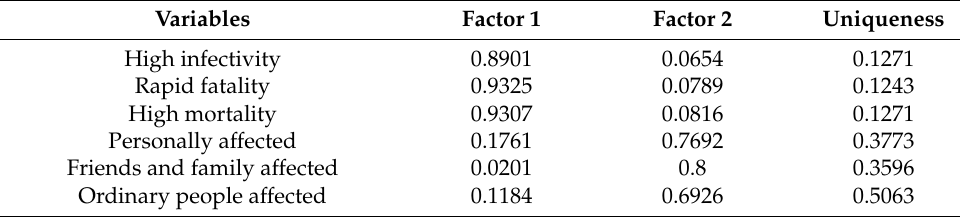
Table 4. Exploratory factor analysis of risk perception of